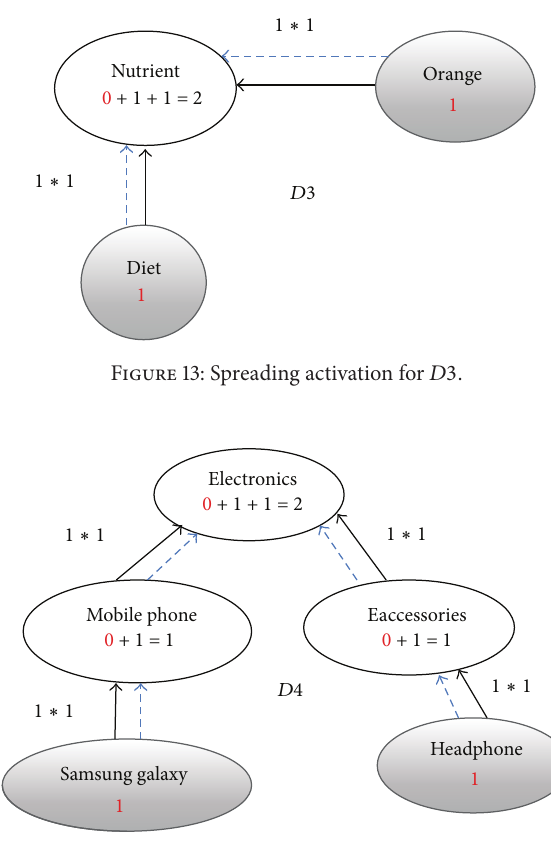
Figure 14: Spreading activation for 𝐷4